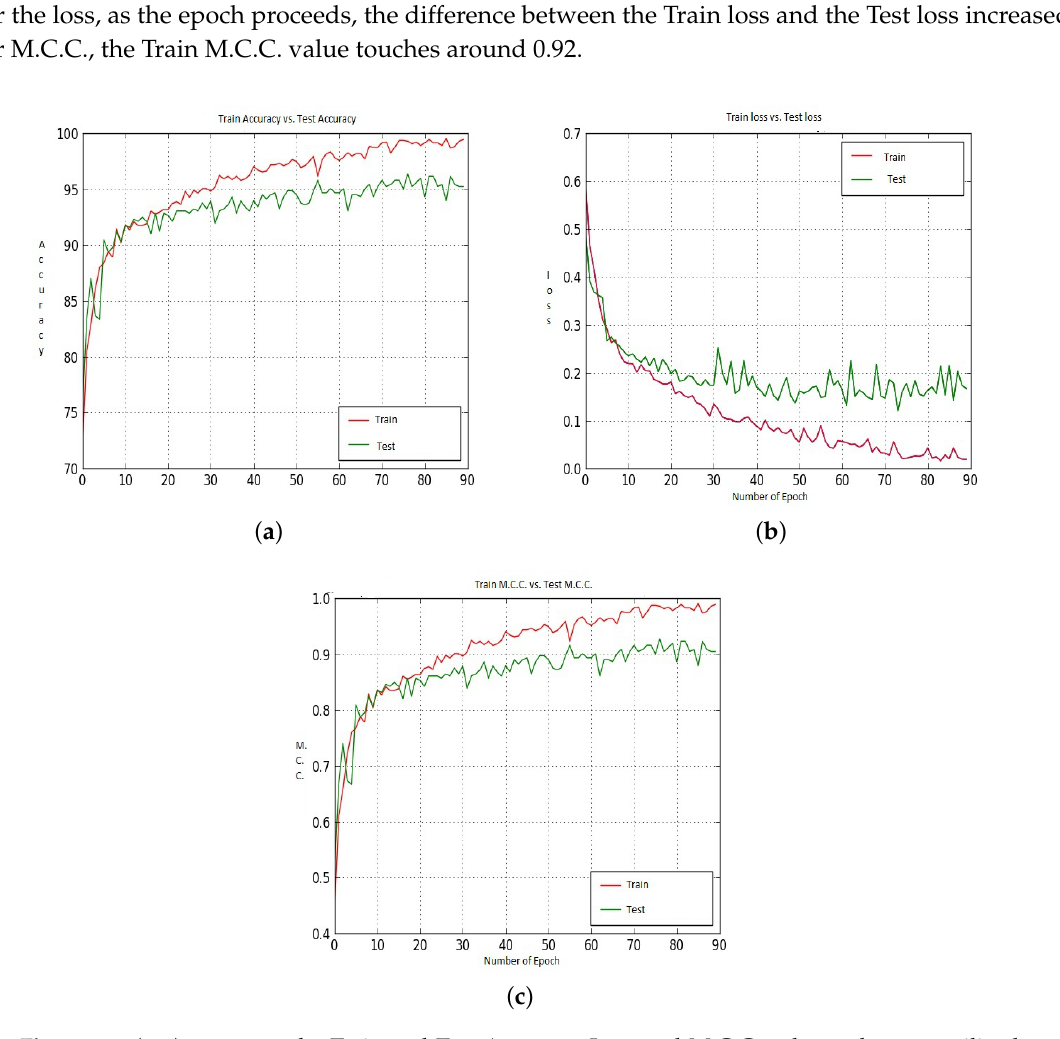
Figure 16. ( a – c ) represent the Train and Test Accuracy, Loss and M.C.C. values when we utilized Model-1, CNN-CH on the 400 ×